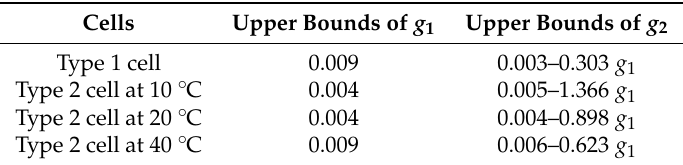
Table 5. The upper bounds of g 1 and g 2 for two types of